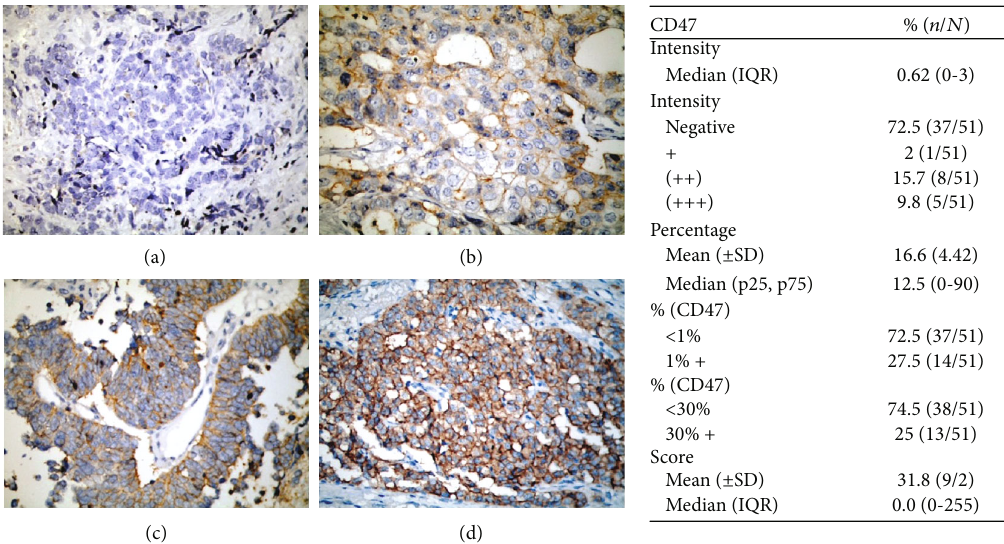
Figure 1: Expression of CD47 in the entire population (51 patients). Images exemplifying negative CD47 expression (a), + CD47 expression (b), ++ CD47 expression (c), and +++ CD47 expression